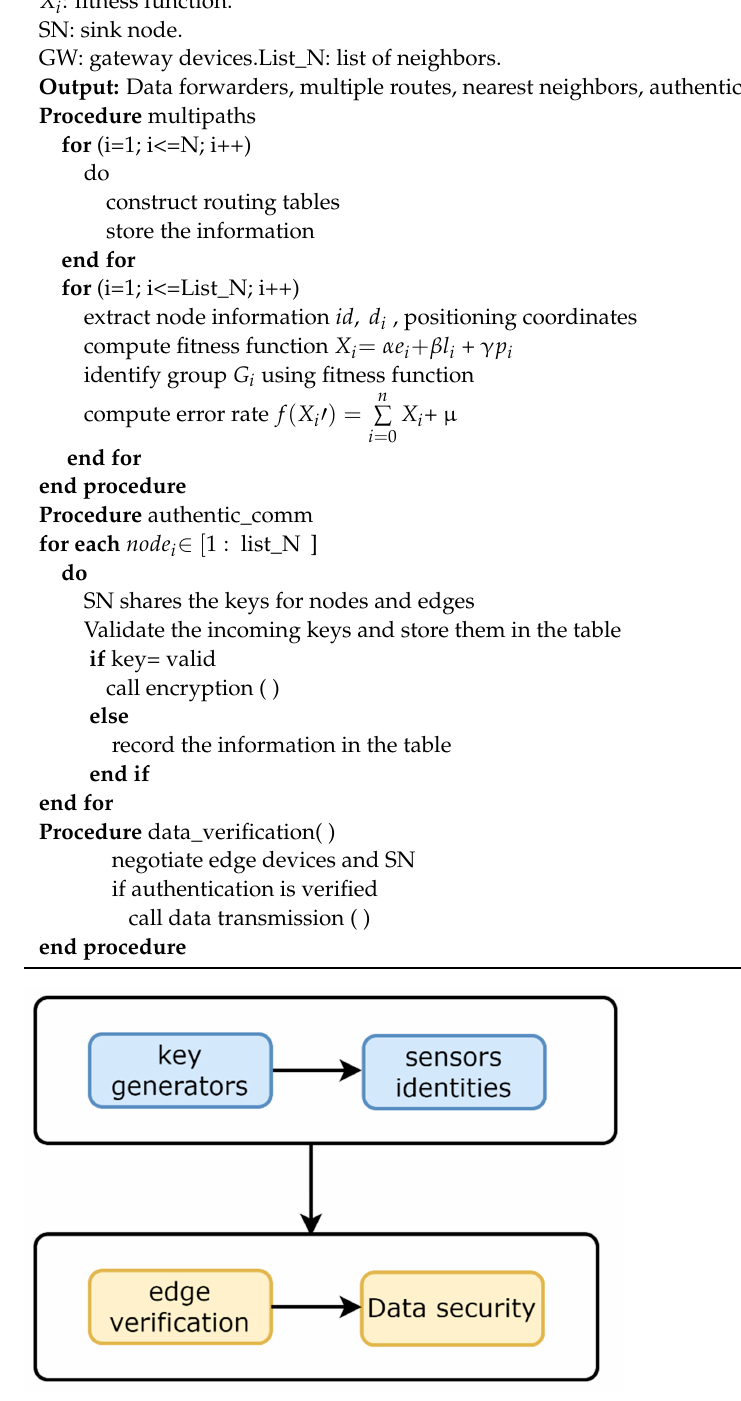
Figure 3. Flow diagram for security measures in the proposed protocol. Algorithm 1: Secure edge-based energy management protocol Input: